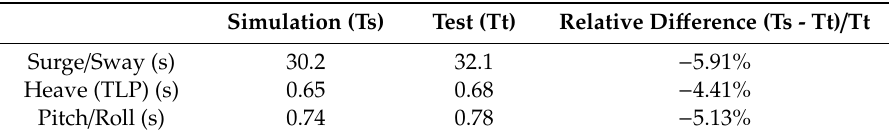
Table 2. Main natural period results of the Serbuoys-TLP system.